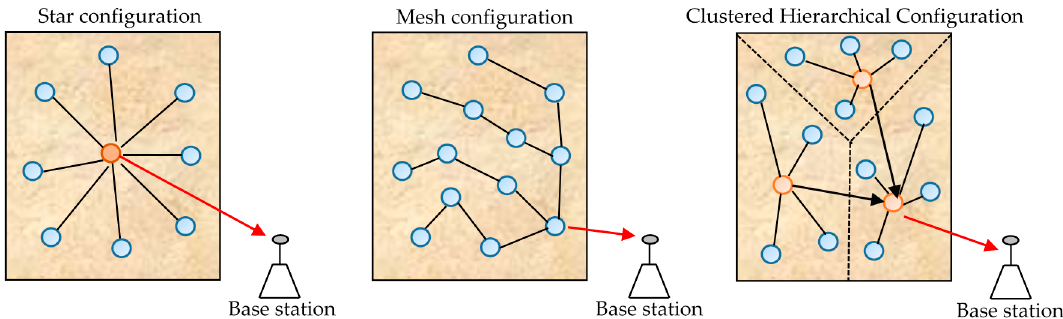
Figure 2. Main topologies of Wireless Sensors Network (WSN).